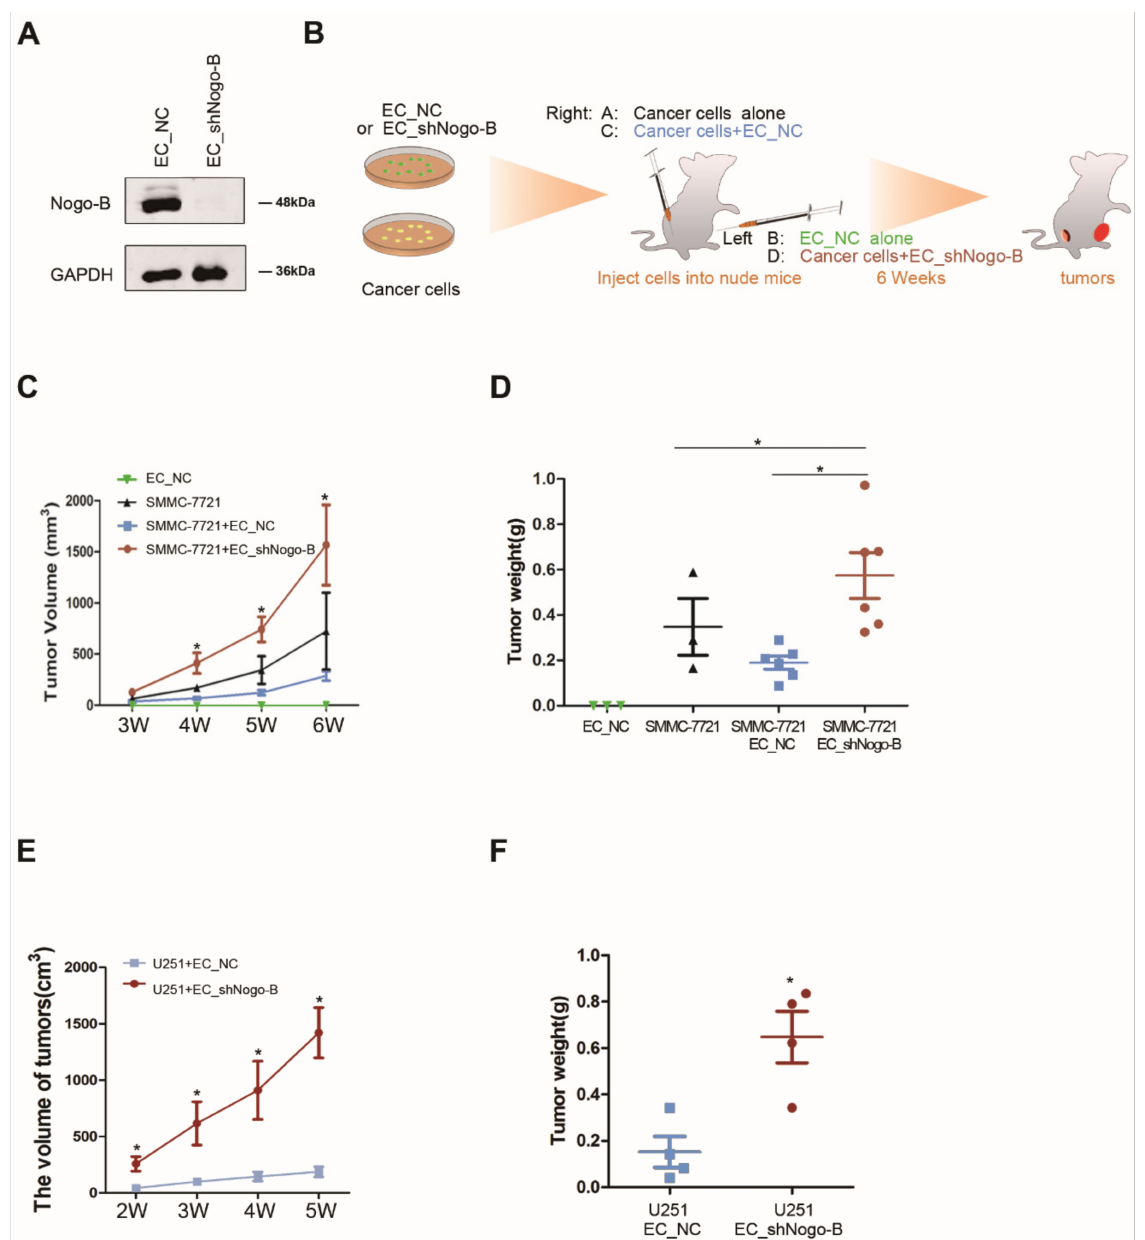
Figure 2. Endothelial Nogo-B silencing promotes tumor growth in mice. ( A ) The efficiency of shNogo-B in EC_shNogo-B was revealed by Western blot assays. ( B ) Schematic of the subcutaneous implantation of distinct cells and cell mixtures in nude mice. ( C , E )The size of xenografted tumor was measured every week and the volume was calculated. “*” indicates p < 0.05. ( D , F ) Tumor weight was measured after the sacrifice of nude mice. “*” indicates p <